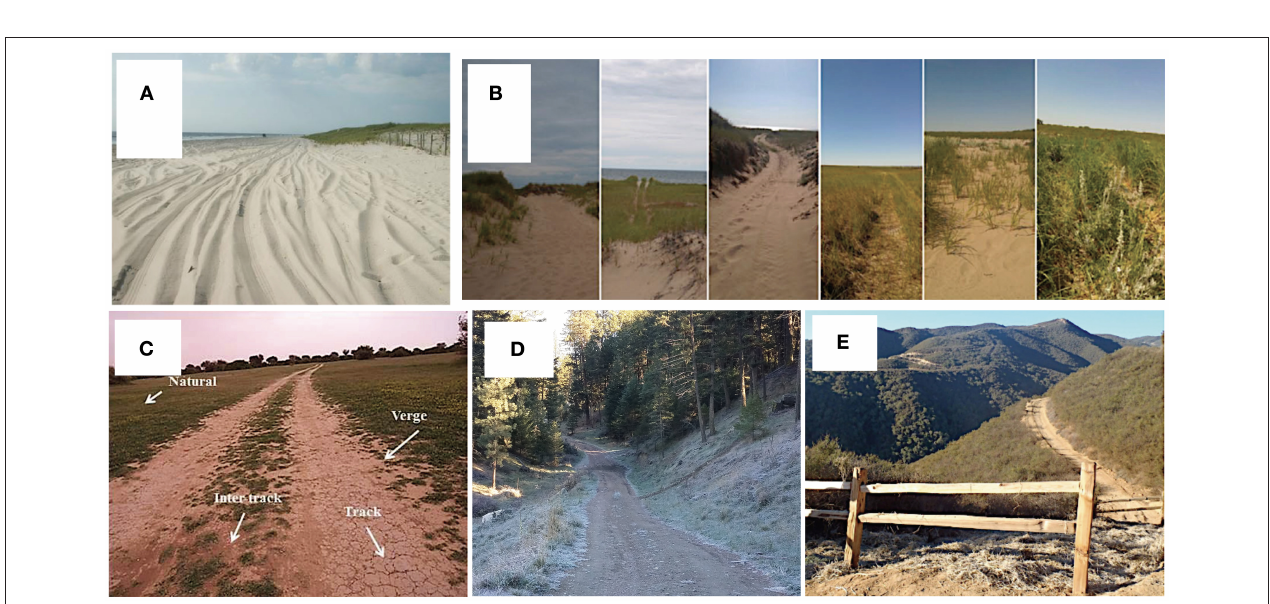
FIGURE 1 | Map of reports of the impacts of light-duty off-road vehicle (ORV) on soils, plants, and animals according to country. Each red dot represents the location of each study ( n = 105). Countries are color-coded according to the percentage of reports each country contributed to the published studies, where darker shades of blue indicate a larger percentage.